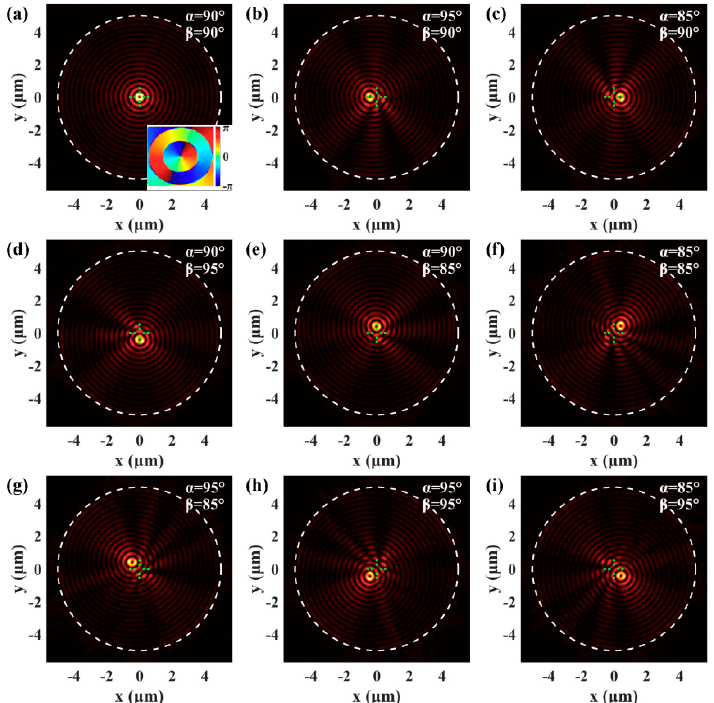
Figure 5. ( a ) For a circular plasmonic lens illuminated by normally incident light, the SPPs’ vortex is excited in the center. ( b – e ) show that the SPPs’ vortex moves along the x -axis or the y -axis when the spatial frequency f x or f y is changed. The SPPs’ vortex can be selectively generated in the first ( f ), second ( g ), third ( h ), or fourth ( i ) quadrant by modulating the spatial frequency.